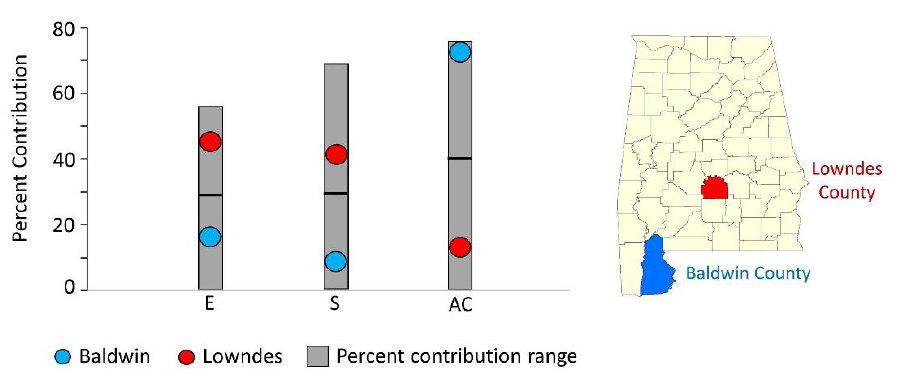
Figure 11. Percent contribution to the COVID-19 Vulnerability Index for the least and most vulner- able counties (Baldwin and Lowndes, respectively). E: exposure; S: sensitivity; AC: adaptive capac- ity. The grey area shows the range of percent values for each indicator.